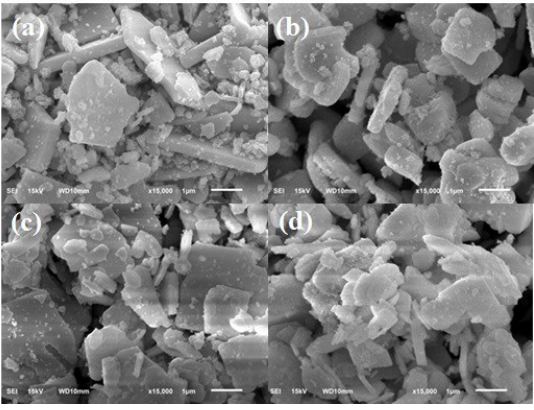
Fig.3. SEM micrographs of SrBi 4 Ti 4- n V n O 15 : (a) n= 0; (b) n = 0.05, (c) n = 0.1, and (d) n =